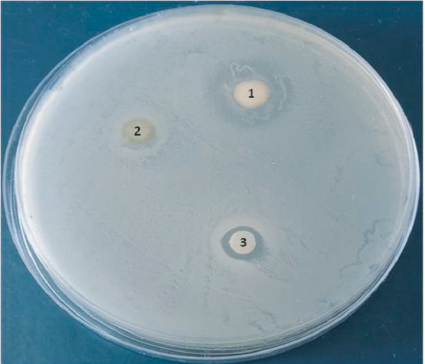
Figure 23: Microbiological activity against Staphylococcus aureus